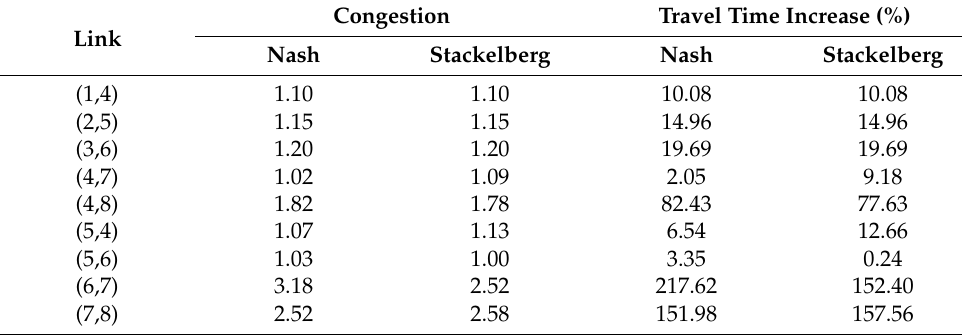
Table 8. Traffic congestion on transport network links for scenario